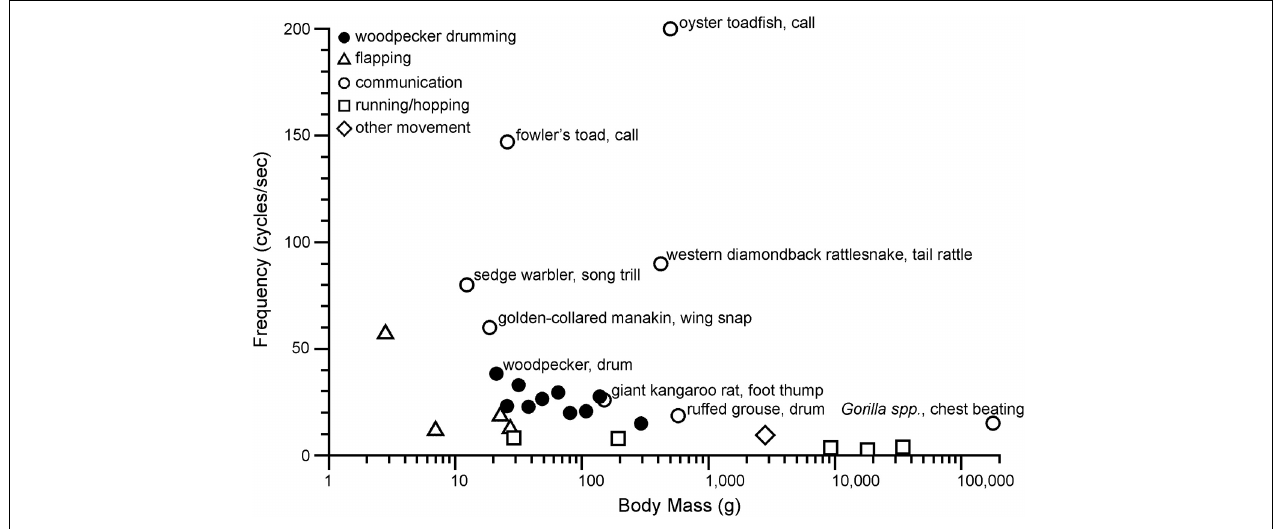
FIGURE 5 | Woodpecker drumming relative to other fast frequency (cycles s − 1 ) movements plotted by body mass (g) on a logarithmic scale. Woodpecker drumming (solid circles) includes from left to right: Japanese pygmy woodpecker, Downy woodpecker, Ladder-backed woodpecker, Nuttall’s woodpecker, Red-cockaded woodpecker, Hairy woodpecker, Acorn woodpecker, Lewis’s woodpecker, Northern flicker, and Pileated woodpecker. To limit woodpeckers to a subset of species that drum, the species with the fastest known drum (Japanese pygmy woodpecker) and North American species were selected. Communication (open circles) organisms are labeled on the graph. Flapping (open triangles) includes from left to right: Ruby-throated hummingbird, little broad-nosed bat, common chaffinch, and downy woodpecker. Running/hopping (open squares) includes from left to right: white mouse, ground squirrel, domestic dog, red kangaroo, and cheetah. Other movement (open diamond) includes domestic cat paw shake. Data sourced from: Zweifel (1968), Dawson and Taylor (1973), Walton and Anderson (1988), Heglund and Taylor (1988), Griffiths (1991), Rome et al. (1996), Schaeffer et al. (1996), Tobalske (1996), Goller and Suthers (1996), Randall (1997), Langefors et al. (1998), Pennycuick (2001), Bullen and McKenzie (2002), Stein and Uy (2006), Fine et al. (2009), Zihlman et al. (2011), Garcia et al. (2012), Hudson et al. (2012), Mahalingam and Welch (2013), Fusani et al. (2014), Miles et al. (2018), Schuppe and Fuxjager (2018), Déaux et al. (2020). See electronic Supplementary Material for more